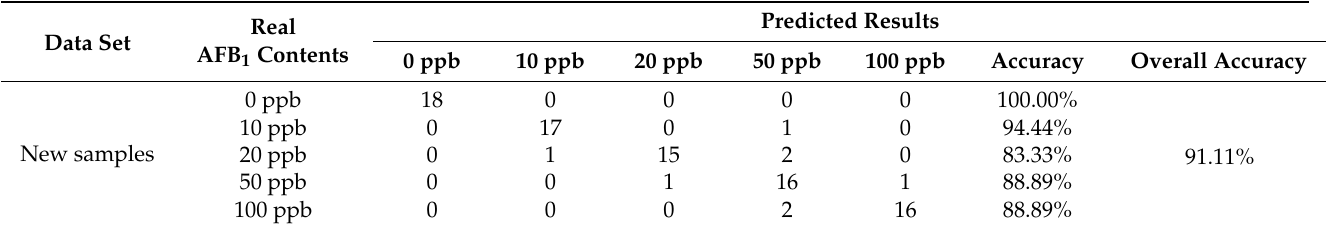
Table 3. Results of model test under full wavelength and different characteristic wavelength selec- tion